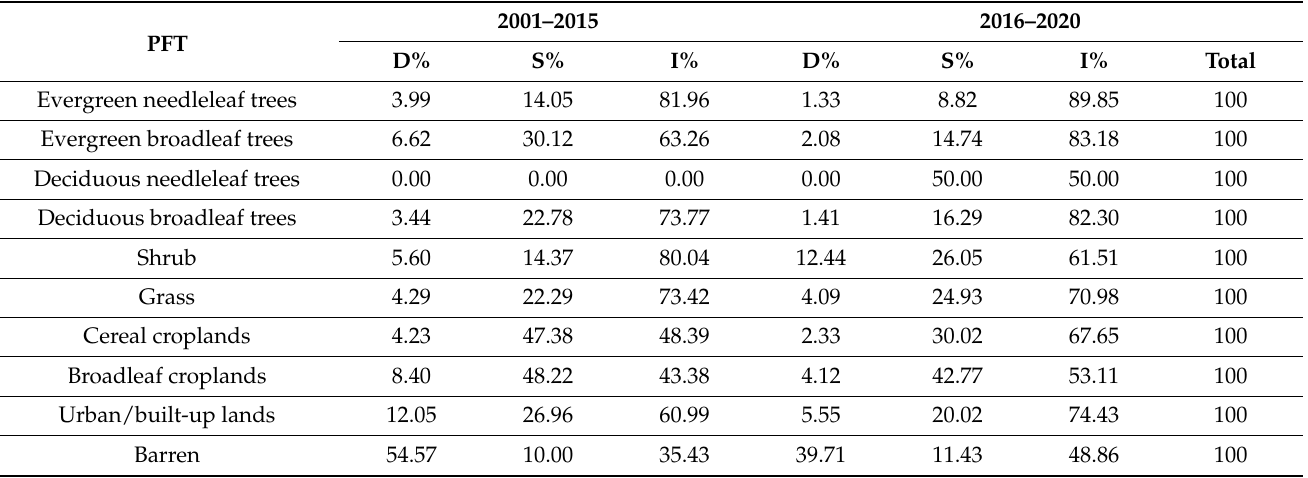
Table 7. Analysis of the land degradation status for each plant functional type in Greece for the baseline and the reporting periods (D: Degraded, S: Stable, I: Improved).